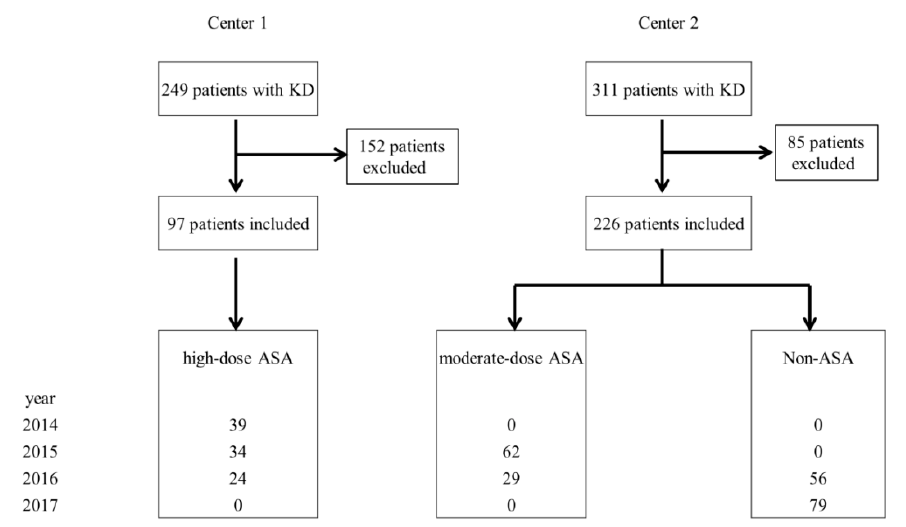
Figure 1. Subject disposition chart. Values of the lowest box are presented as year and number of patients. KD, Kawasaki disease; ASA, acetylsalicylic acid.